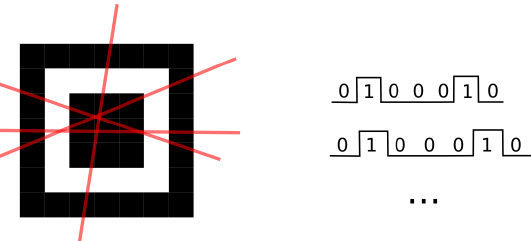
Figure 7. Finder pattern line scans and two exemplary profiles of 1:1:3:1:1 proportions (dark/bright/dark/bright/dark) depending on the line scan